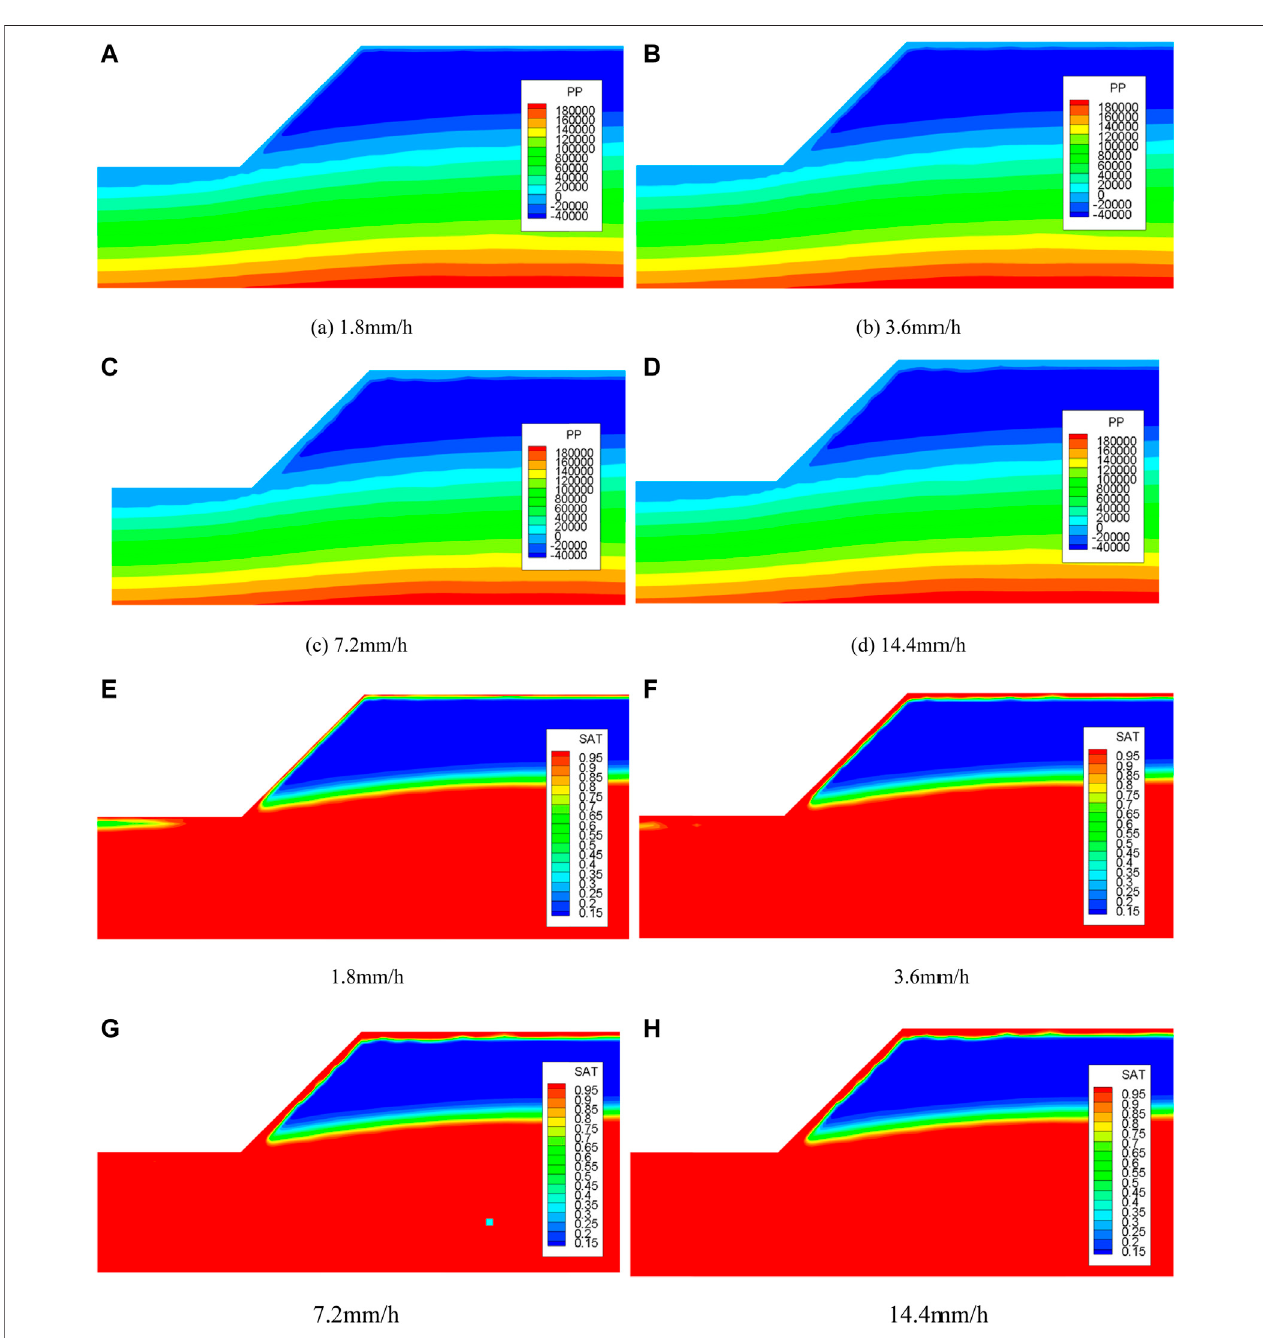
FIGURE 9 | Pore water pressure and saturation under different rainfall intensity: (A) Pore water pressure, (B) Pore water pressure, (C) Pore water pressure, (D) Pore water pressure, (E) Degree of saturation, (F) Degree of saturation, (G) Degree of saturation, (H) Degree of saturation.